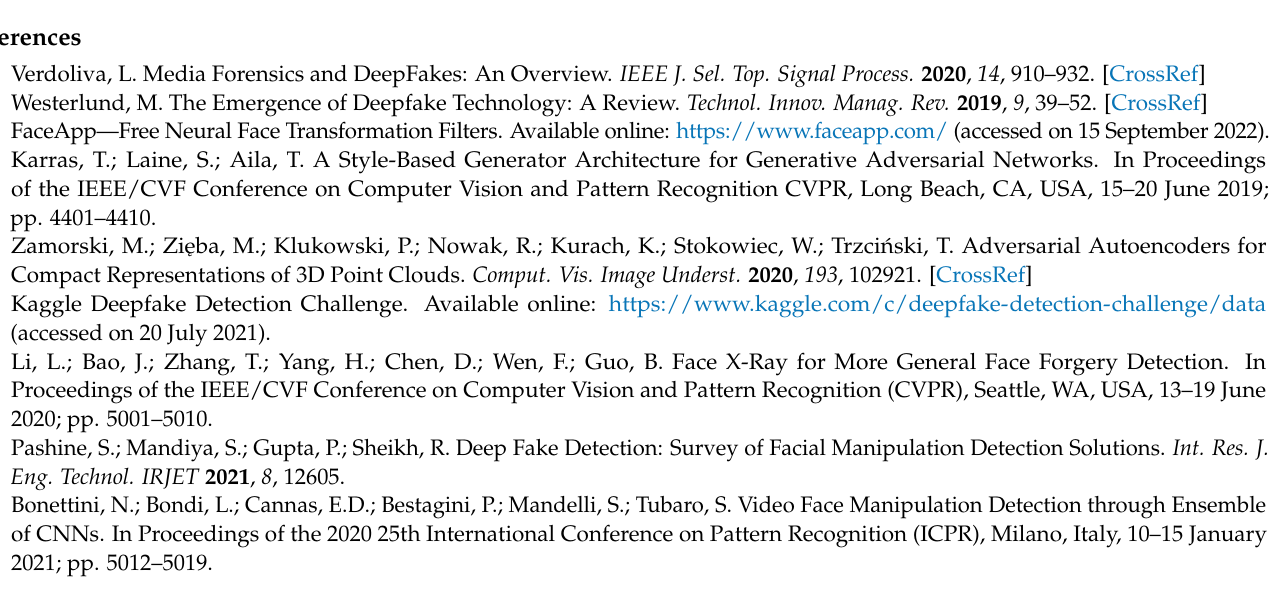
Figure A2. Comparison of ( a ) train and ( b ) validation accuracy versus epoch obtained with various